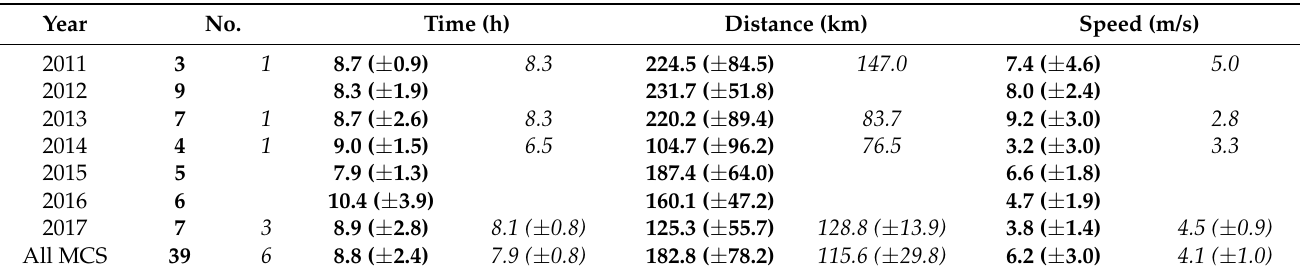
Table 1. Propagation speed estimation using technique 2 (change in centroid position from initial to final lifecycle stage) for MCS in the Band A. Means and ± one standard deviation in parenthesis. Bold and italic numbers correspond to Trajectory 1 and 3, respectively.